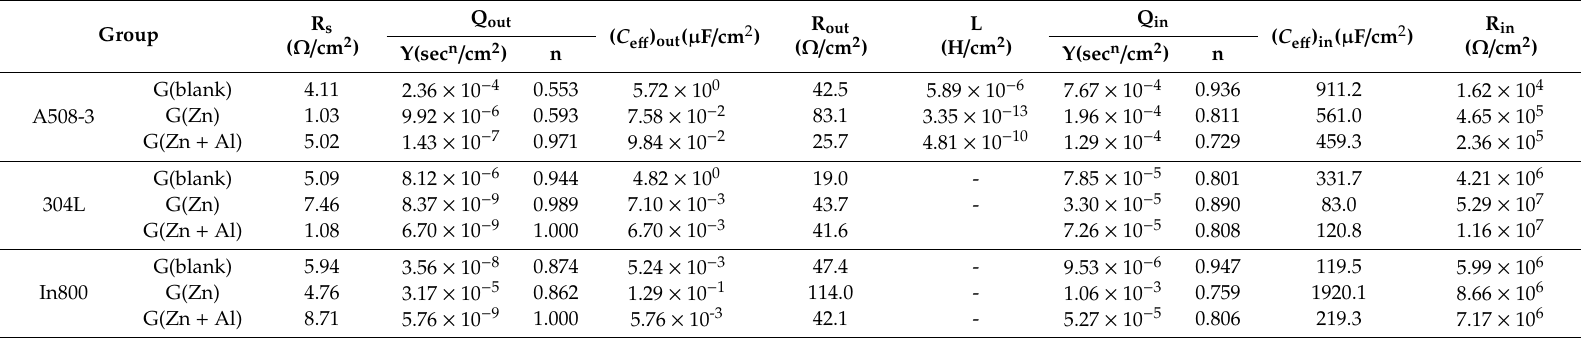
Table 4. The fitting parameters of the electrochemical impedance spectroscopy (EIS)